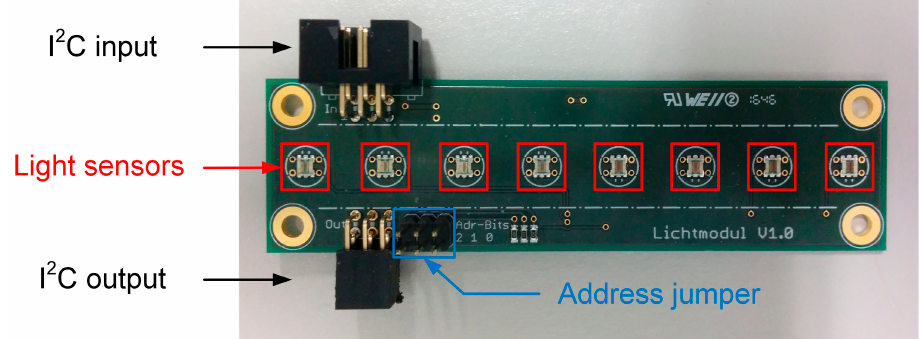
Figure 10. Top view of the light module.